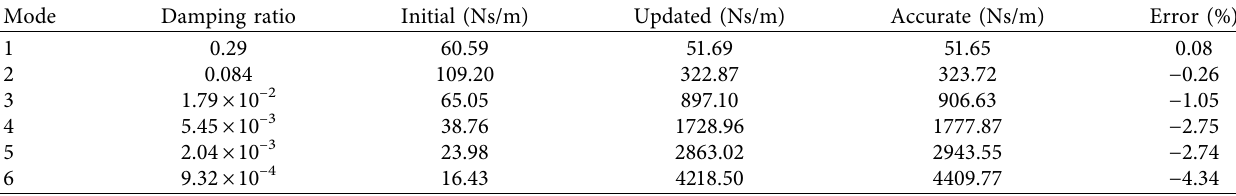
Table 4: Comparison of the diagonal elements of the modal damping matrix before and after updating for case 1. Mode